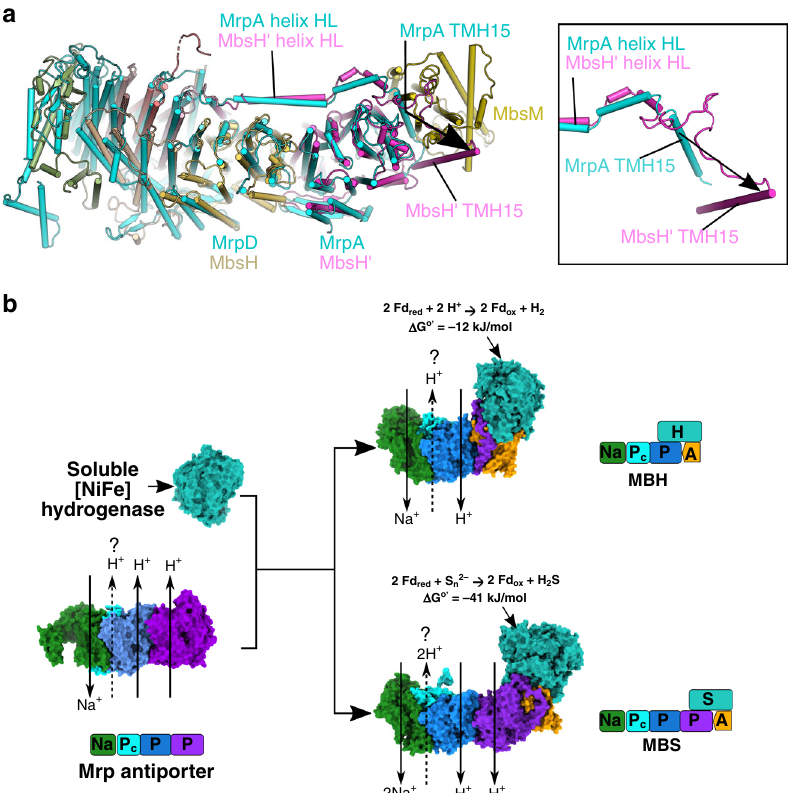
Fig. 4 Evolutionary relationship of Mrp, MBH, and MBS. a Comparison of the MBS membrane arm with the Mrp structure (PDB ID: 6Z16). The structures are aligned by superimposing MbsH and MrpD. The MBS subunits are colored as Fig. 1c and the Mrp is in cyan. Mrp structure is similar to MBS, with the conserved helix HL holding the two antiporter-like subunits in both complexes (MrpA and MrpD; MbsH and MbsH ’ ). Notably, the MbsH ’ TMH15 immediately preceding helix HL moves a large distance, as compared to MrpA TMH15, to pack tightly against MbsM in order to accommodate MbsM in the MBS structure (see inset panel to the right). b A possible evolutionary pathway from Mrp to MBH and to MBS. Mrp antiporter: PDB ID 6Z16; cytoplasmic [NiFe] hydrogenase: PDB ID 2FRV; MBH: PDB ID 6CFW. The question mark above the proton path in each antiporter module indicates the tentative nature of the assignment. Shown above the MBH and MBS structures are the reductive reactions that they catalyze and the associated free energy changes. Located around each complex is the respective modular architectures of the Mrp-derived respiratory complexes. These modules are: Na (green), sodium ion path; P (blue and purple), H + path(s) formed within a single subunit; Pc (cyan), composite H + path formed by multiple small subunits; A (orange), membrane anchor for the peripheral arm; H (turquoise), peripheral arm for proton reduction; S (turquoise), peripheral arm for polysul fi de